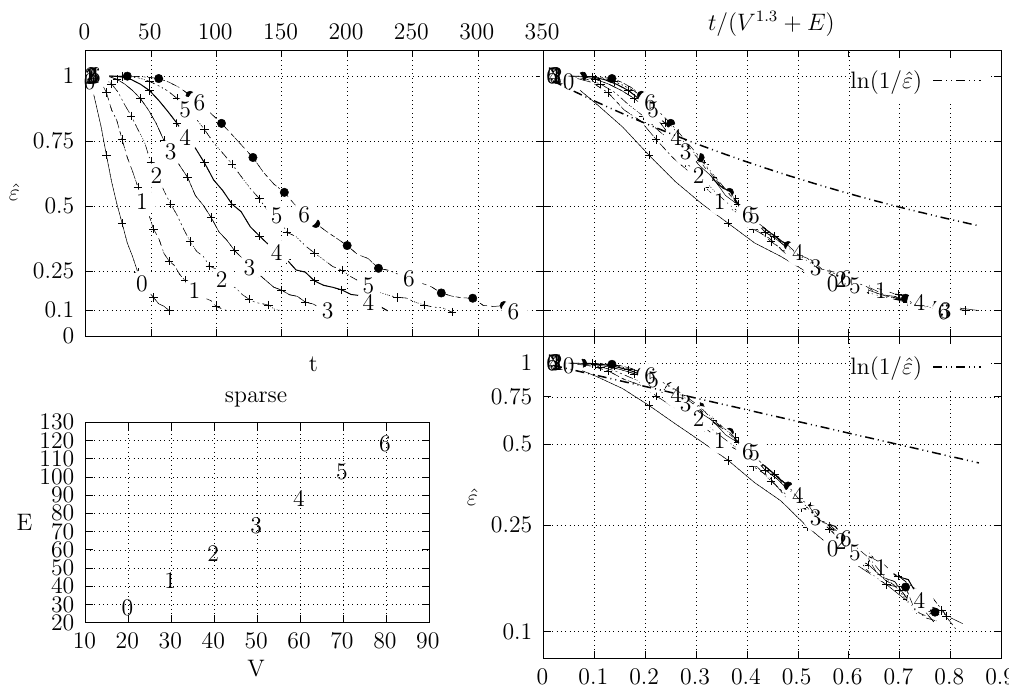
Figure 18. Estimation of variation distance as a function of the number of iterations for sparse graphs (see Section 4.3.1 for details).